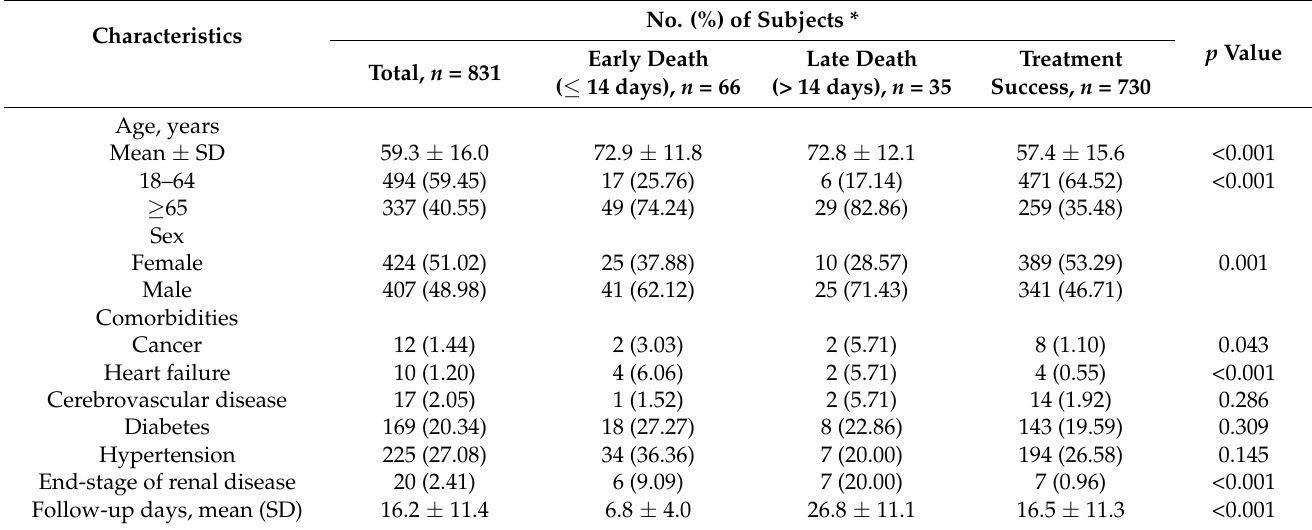
Table 1. Patients’ characteristics by treatment outcome.